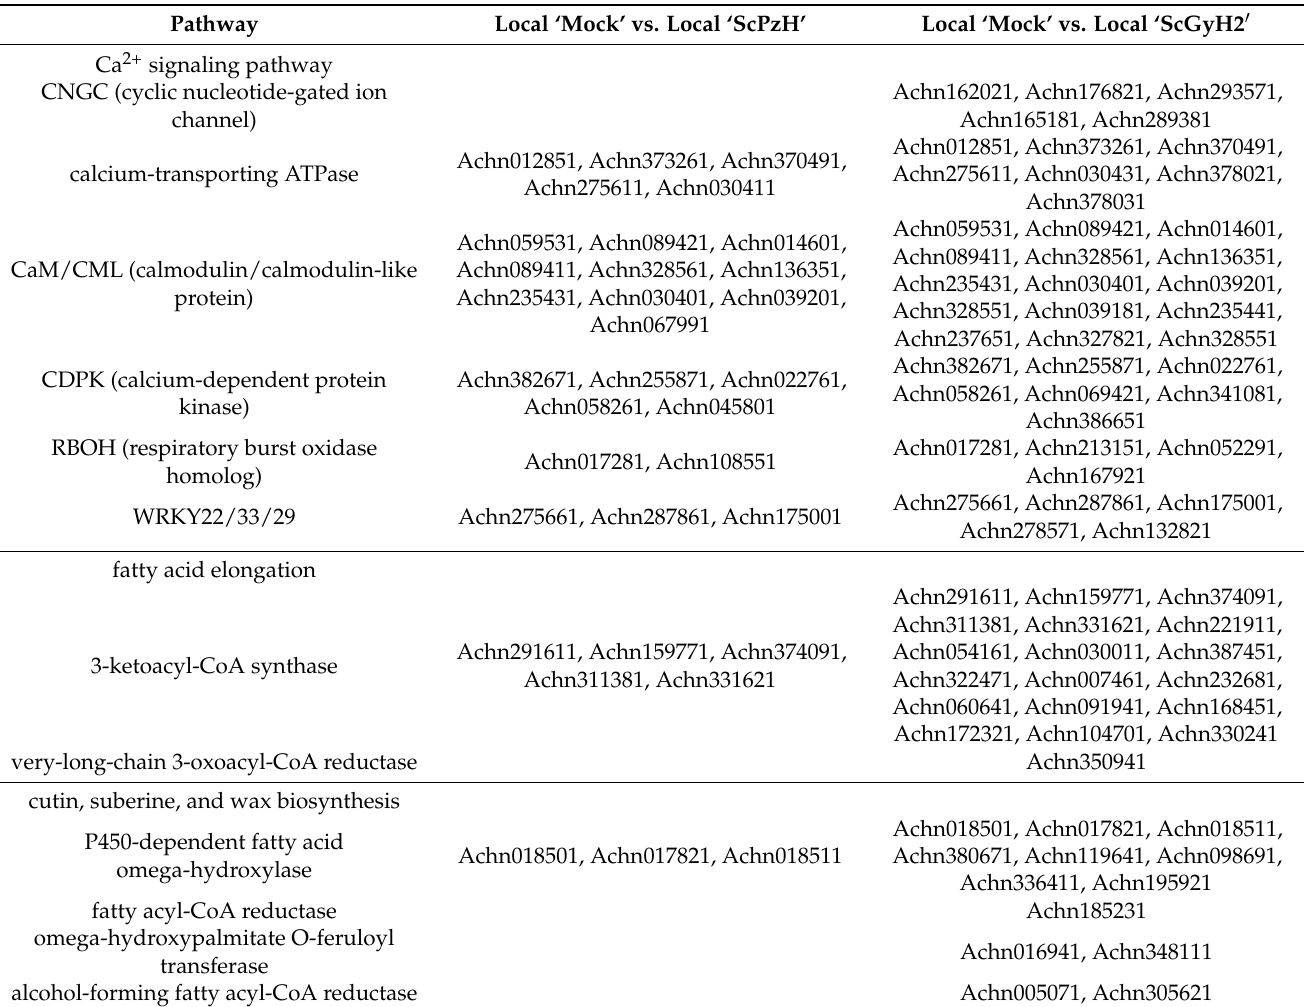
Table 2. Down-regulated genes in the Ca 2+ signaling pathway, fatty acid elongation, cutin, suberine, and wax biosynthesis in local Psa -inoculated tissues. Pathway Local ‘Mock’ vs. Local ‘ScPzH’ Local ‘Mock’ vs. Local ‘ScGyH2